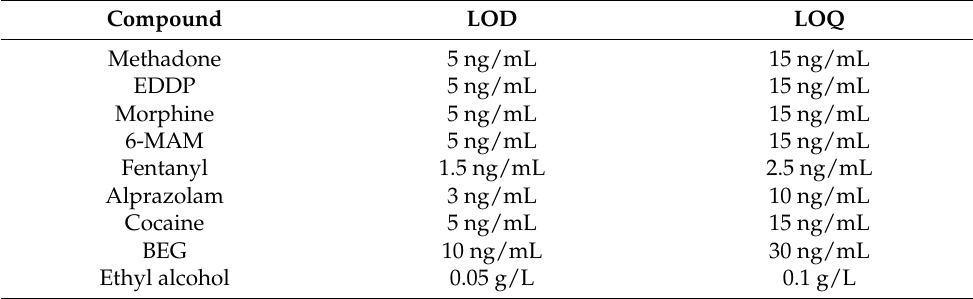
Table 1. LODs and LOQs for all substances analyzed in the study.